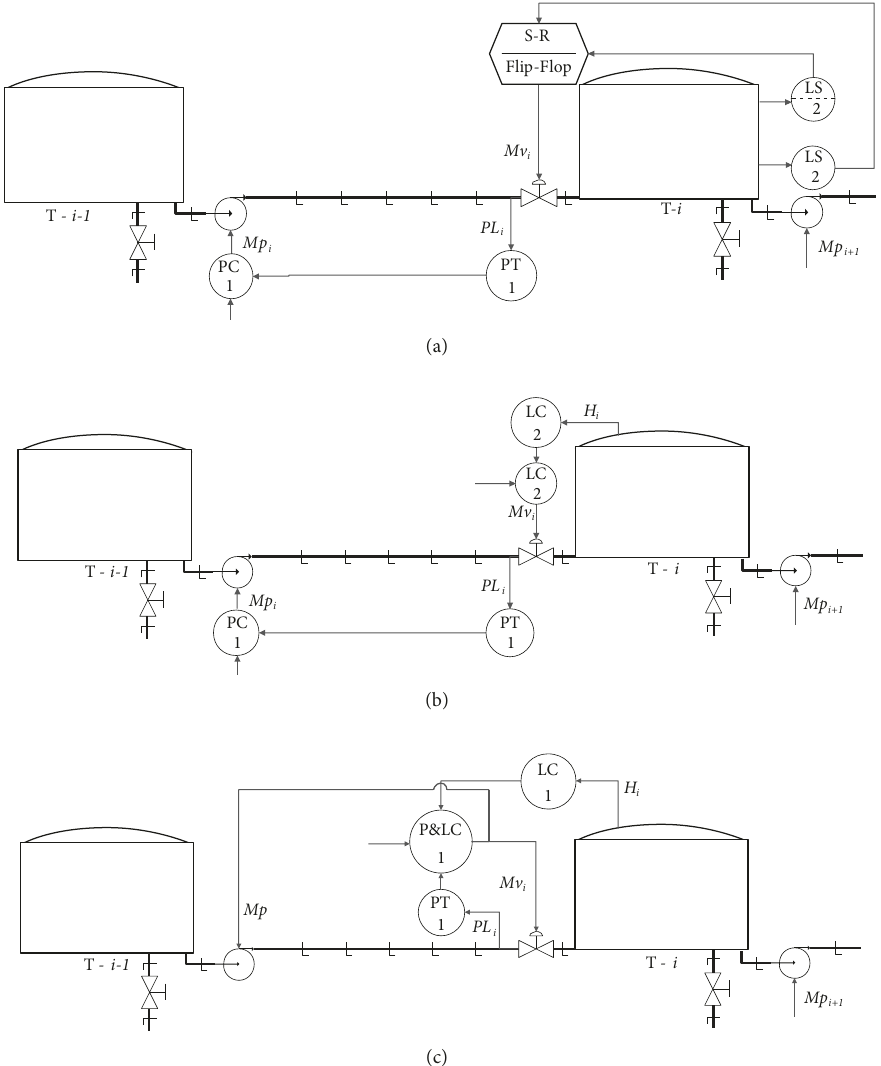
Figure 7: Pipeline Section P&ID for (a) Configuration 1, (b) Configuration 2, and (c) Configuration